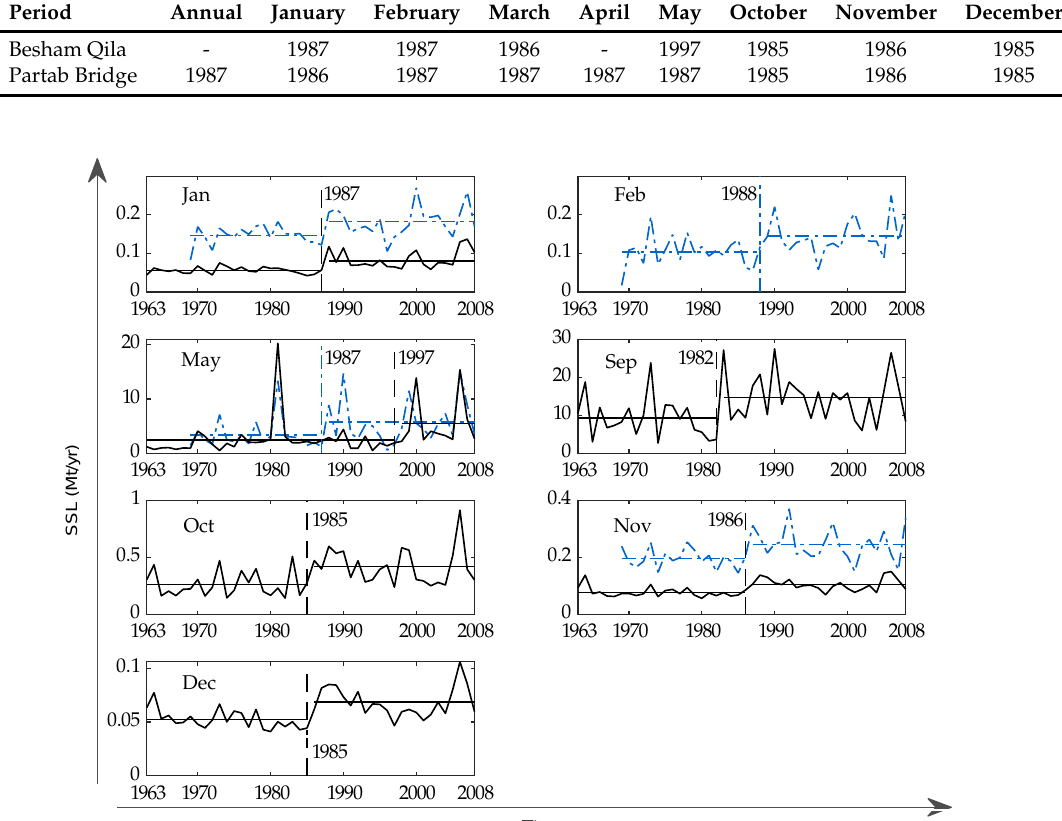
Figure 7. Significant change points in monthly SSLs determined using Pettitt test; black denotes Partab Bridge, and blue denotes Besham